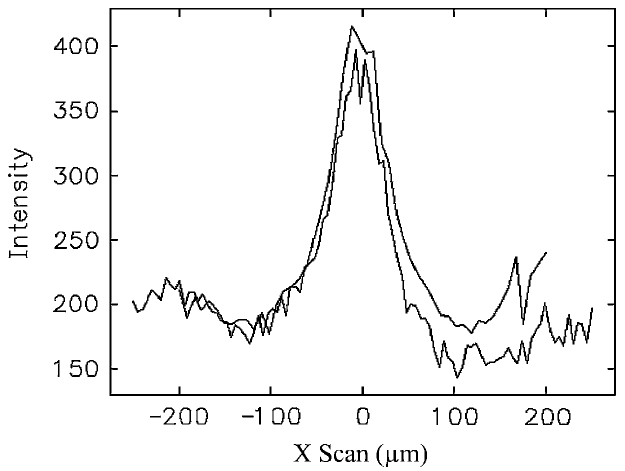
FIG. 3. FIR CTR autocorrelation performed after the chicane with a near maximum compression setup for the PC gun. The two scan profile widths are about 65 (cid:1) m (FWHM) correspond- ing to a path length difference of 130 (cid:1) m between the mirror